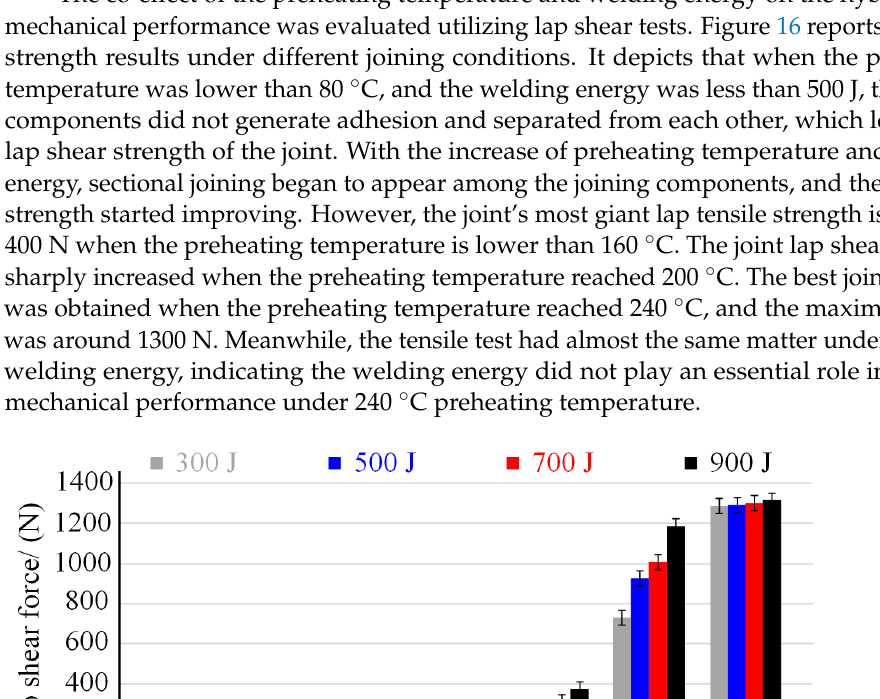
ries. The tests in the yellow frame in Figure 17 belong to category 1, the tests in the blue frame belong to category 2, and the red frame is category 3. Category 1 had the worst other parts, and only a tiny area of PA6 film was fused with the CFRTP chopped sheet. The dashed red line in Figure 18 shows the representative fracture surface morphology, which represents the joining area between the PA6 film and the CFRTP chopped sheet. Only a tiny space was melted between the PA6 film and CFRTP chopped sheet and got adhesive under the welding energy oscillation effect, and under the different joining en- ergy, the joining area was different. It indicates that the lowest energy did not adequately join the hybrid adherents. Figure 17. Joining process window of the SPCC-CFRTP hybrid joint by the UPW.